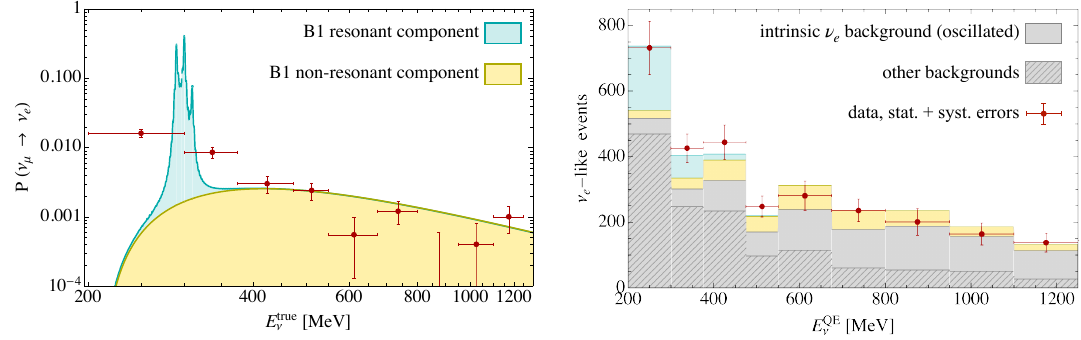
Figure 7 . Left panel: the ν µ → ν e appearance probability at MiniBooNE predicted by the benchmark model B1 specified in (3.20), (3.22a). The non-resonant component (yellow region) is the expectation from this model if the triple-resonance mechanism were ‘turned off’ (i.e., if the active-quasi-sterile mixing angles θ were set to zero). The red data points with , θ , θ S 1 S 2 S 3 error bars were taken from figure 21 of [22]; they assume E true , which is a very coarse ∼ E QE ν ν approximation. As such, they should be interpreted as a qualitative measure of MiniBooNE’s anomalous appearance probabilities. Right panel: the expected ν appearance event rate at e MiniBooNE predicted by the full model benchmark B1. The intrinsic (beam) ν component of e the background takes ν oscillations into account. The red data points correspond to the e 6→ ν e measurements reported by MiniBooNE in [22], and the error bars include both statistical and systematic